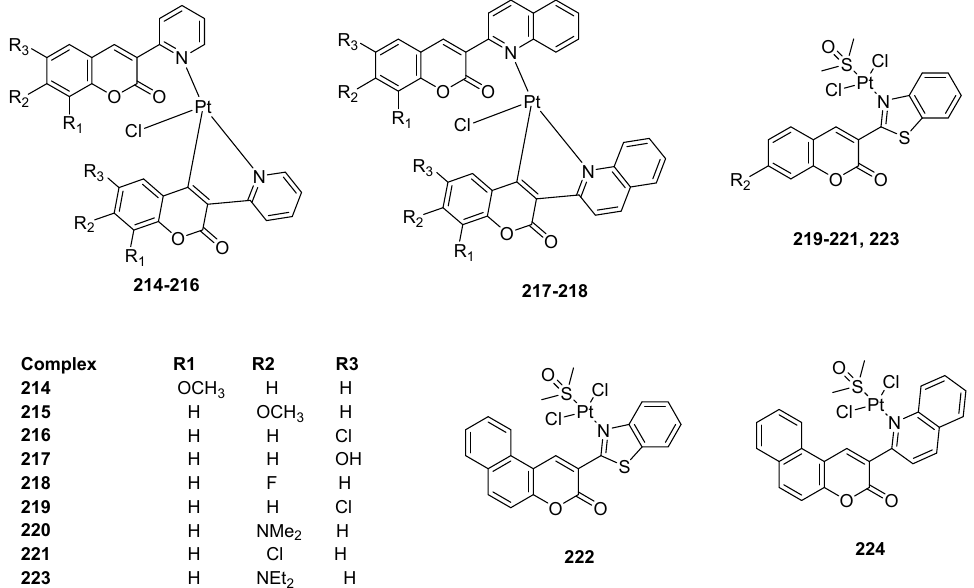
Figure 70. Chemical structure of derivatives 214 – 224 .